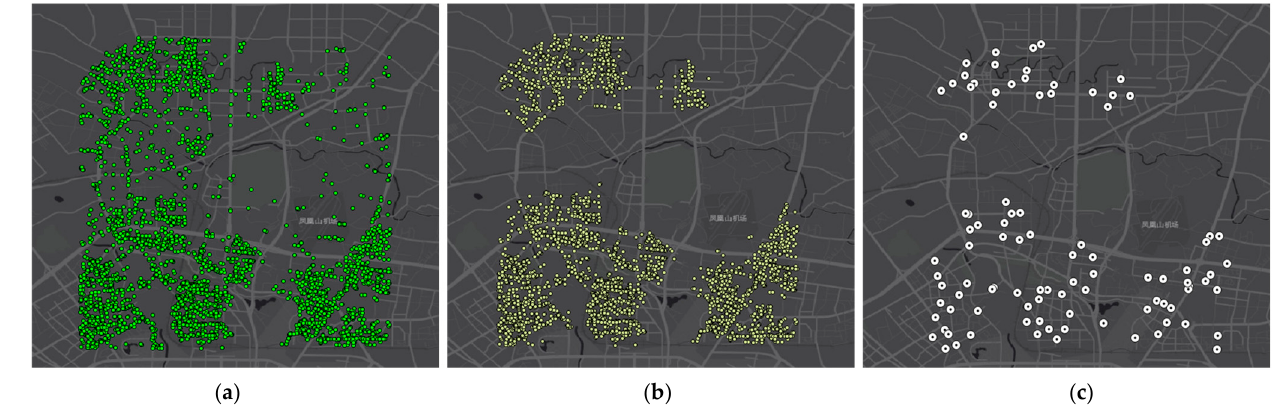
Figure 6. Shuttle stops generation. ( a ) All O/D locations; ( b ) clustered locations; ( c ) generated shuttle stops.